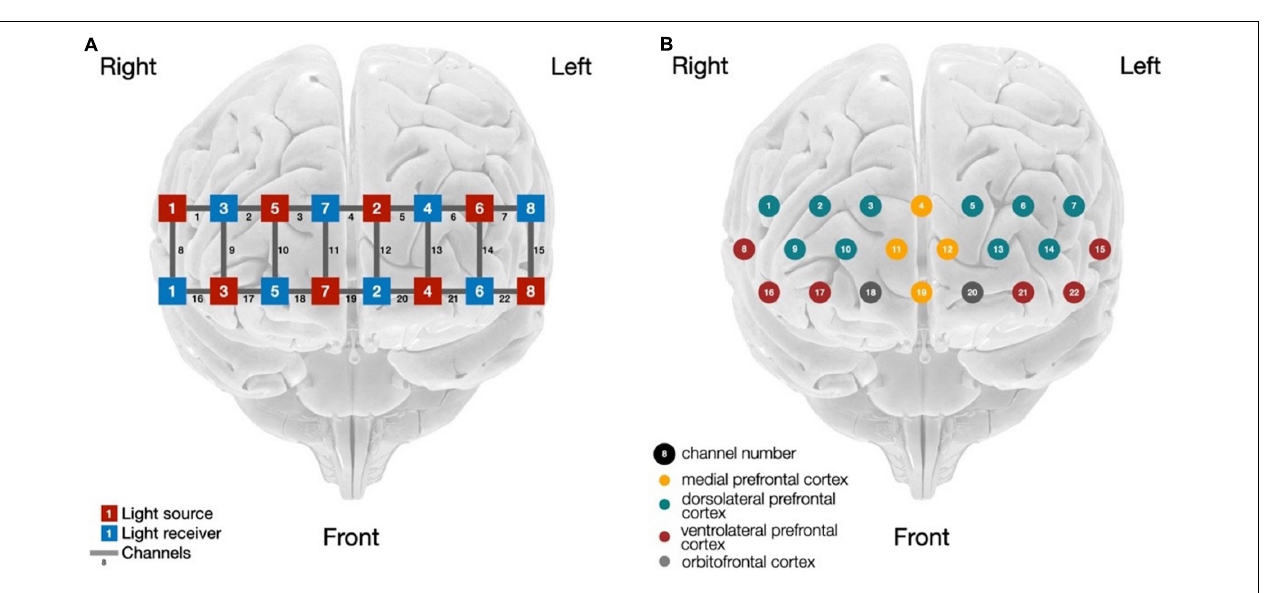
FIGURE 2 | fNIRS sensors and channels: (A) Sensors configuration; (B) Channels and sub-regions in the